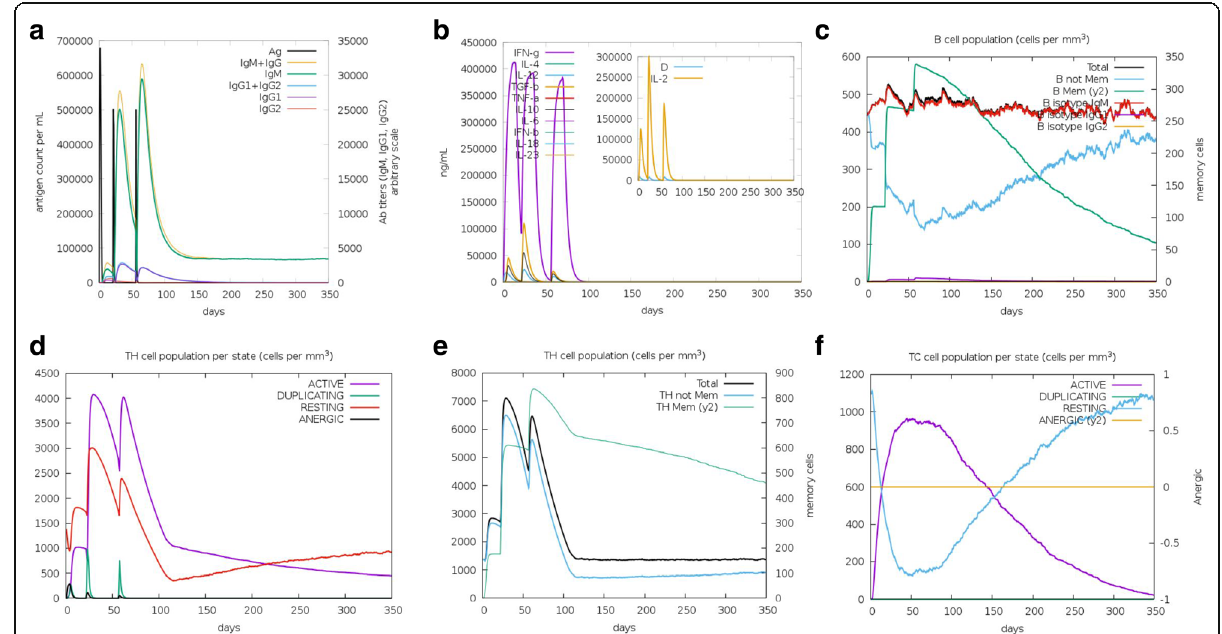
Fig. 3 Immune response to the vaccine construct in mammalian system generated through CIMMSIM server. a Antigen count (per ml) and antibody levels (IgM, IgG1, and IgG2). b Cytokine levels in the system (ng per ml). c B cell population (per mm 3 ). d TH cell population per state (per mm 3 ). e TH cell population (per mm 3 ). f TC cell population per state (per mm 3